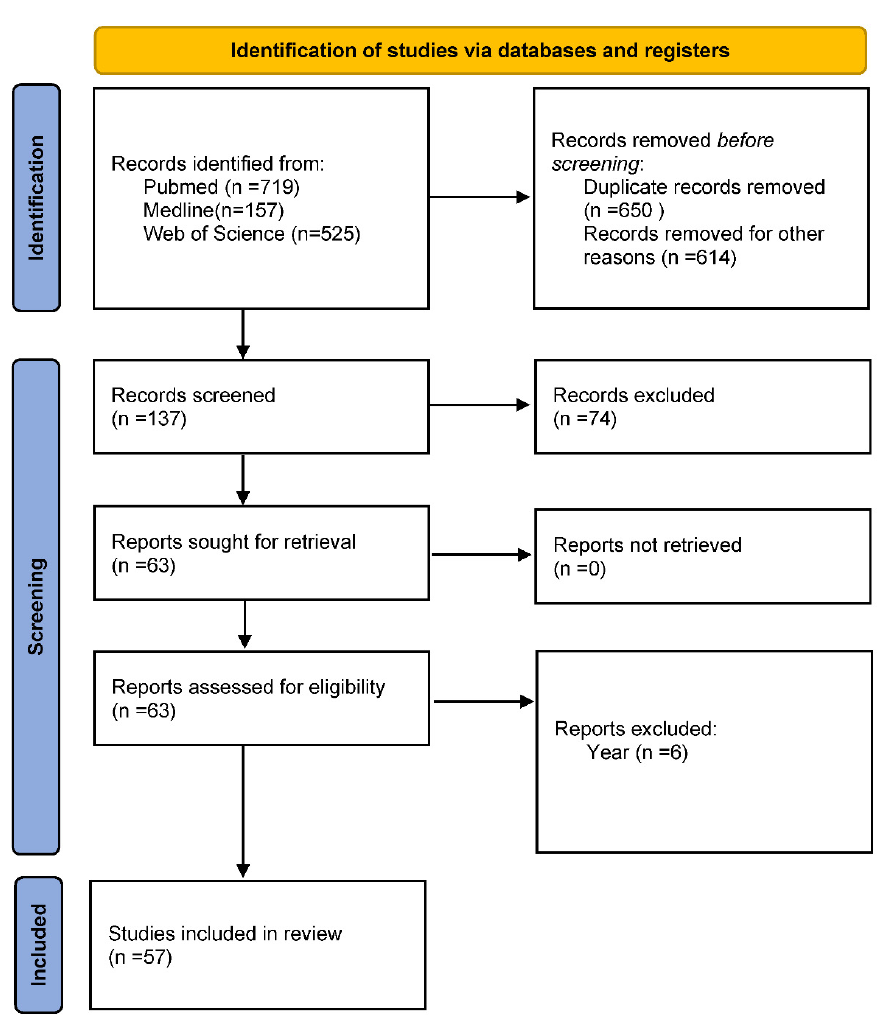
Figure 2. PRISMA flow diagram. Description of the search strategy and exclusion/inclusion criteria.